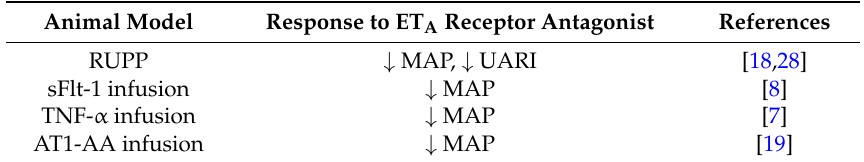
Table 1. Summary of responses to ET A receptor antagonists in animal models of